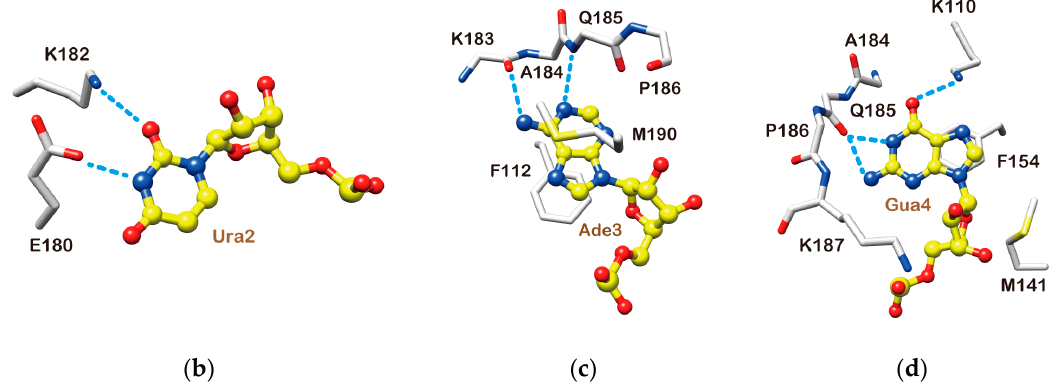
Figure 3. r(UAG) recognition by Msi1 RBD2(109–191). ( a ) The Ura2 base fits in a shallow basin. Msi1 RBD2(109–190) is depicted as a ribbon model with a semi-transparent molecular surface. F112 (orange), E180 (green), and K182 (blue), whose side chains are shown (oxygen and nitrogen atoms in red and blue, respectively), form a rim, while G114 (magenta) and G115 (cyan) form the bottom of the basin. RNA is shown as a ball-and-stick model: carbon is color-coded yellow (Ura2) and white (Ade3), while nitrogen, oxygen, and phosphorus are color-coded blue, red, and yellow, respectively; ( b ) Recognition of Ura2. Intermolecular hydrogen bonds, Ura2 N3-E180 O ε and Ura2 O2-K182 H ζ , are formed; ( c ) Recognition of Ade3. The Ade3 base stacks onto the F112 aromatic ring, and the M190 side chain likely makes a van der Waals contact with Ade3, such that the adenine is sandwiched between F112 and M190. Hydrogen bonds, Ade3 H6-K183 O and Ade3 N1-Q185 HN, are also formed. S δ of M190 is colored yellow; ( d ) Recognition of Gua4. The Gua4 base stacks onto the F154 aromatic ring, and hydrogen bonds, Gua4 N1-Q185 O, Gua4 H2-Q185 O, and Gua4 O6-K110 H ζ , are also formed. The M141 side chain makes a van der Waals contact with the ribose of Gua4. A salt bridge between K187 H ζ and the 5 ′ phosphate group of Gua4 may also be formed. S δ of M141 is colored yellow. RNA is shown as a ball-and-stick model: carbon (yellow), nitrogen (blue), oxygen (red), and phosphorus (yellow). Hydrogen bonds are indicated by cyan dotted lines.